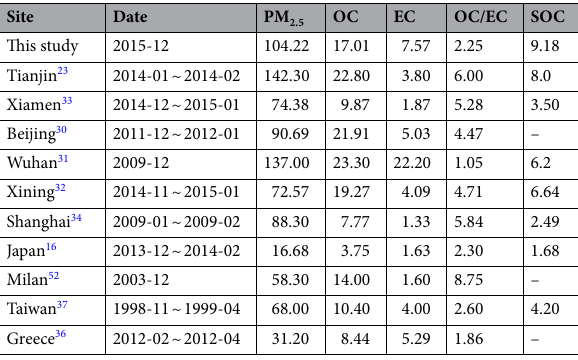
Table 1. OC/EC and SOC in PM 2.5 in different